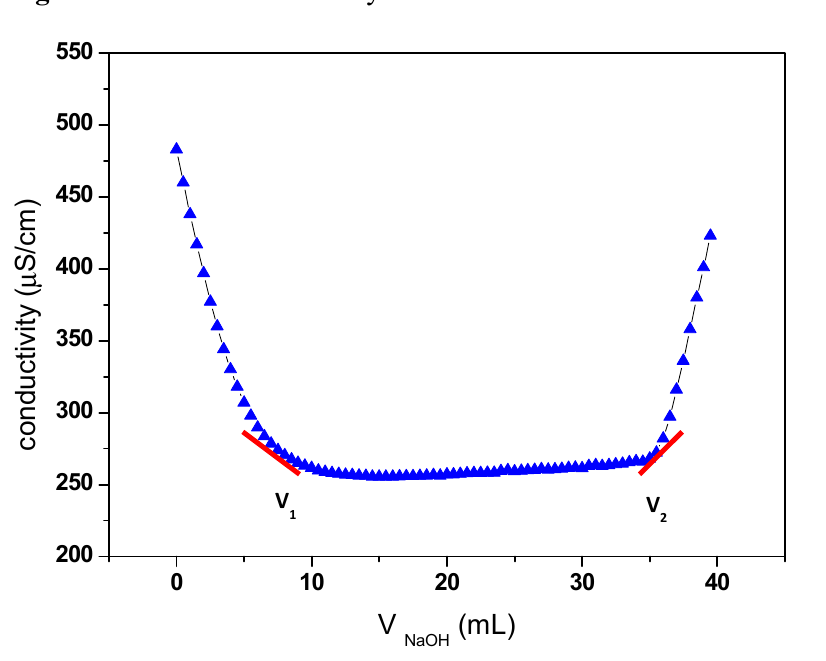
Figure 1. Electric conductivity titration of the oxidized